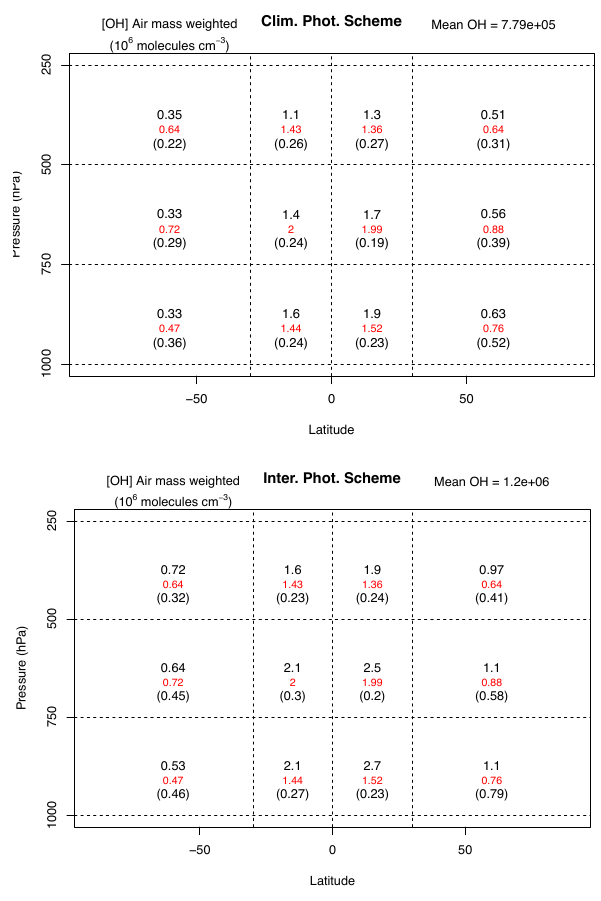
Fig. 6. OH distribution, weighted as in (Lawrence et al., 2001), as a function of height and latitude. The black numbers are the model values, the red numbers are from the Spivakovsky et al. (2000) cli- matology (obtained from Lamarque et al., 2012) and the numbers in brackets the standard deviation of the grid cell values used to ob- tain the average in the model. Top plot with offline photolysis and bottom plot with interactive